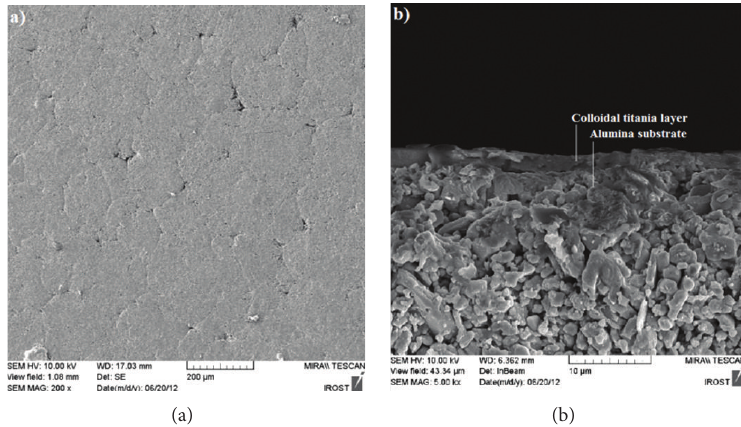
Figure 7: The FESEM images of the (a) top surface and (b) cross-section of the colloidal titania-coated alumina substrates.